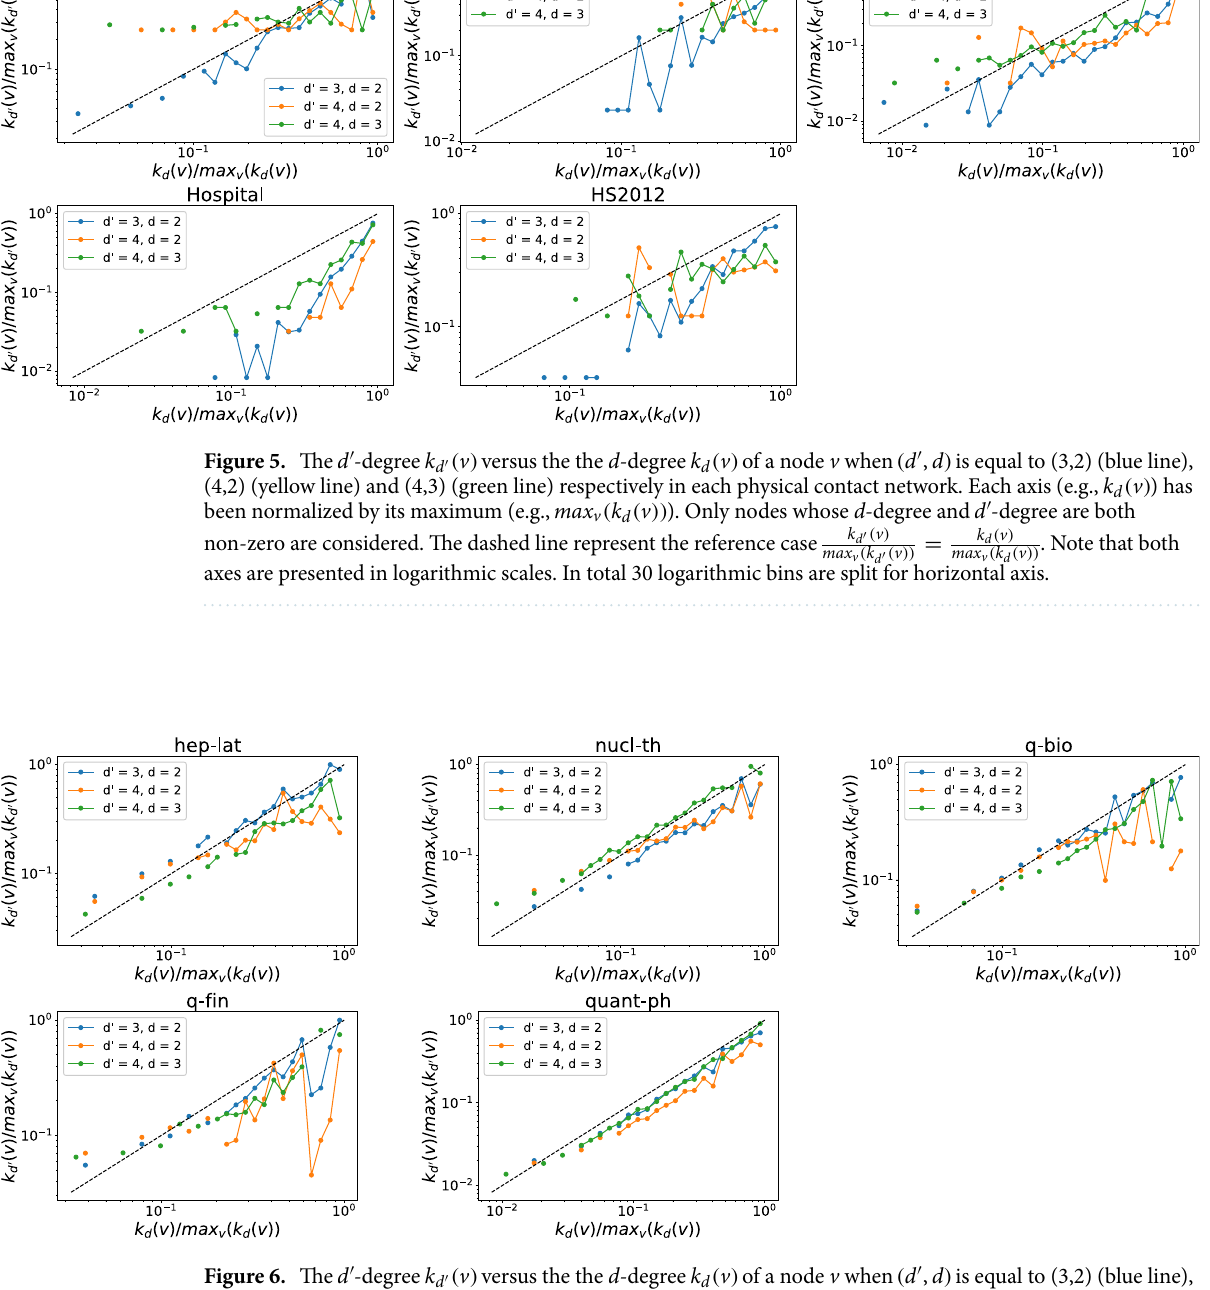
Figure 6. The d ′ -degree k d ′ ( v ) versus the the d -degree k d ( v ) of a node v when ( d ′ , d ) is equal to (3,2) (blue line), (4,2) (yellow line) and (4,3) (green line) respectively in each collaboration network. Each axis (e.g., k d ( v ) ) has been normalized by its maximum (e.g., max v ( k d ( v )) ). Only nodes whose d -degree and d ′ -degree are both non-zero are considered. The dashed line represent the reference case axes are presented in logarithmic scales. In total 30 logarithmic bins are split for horizontal